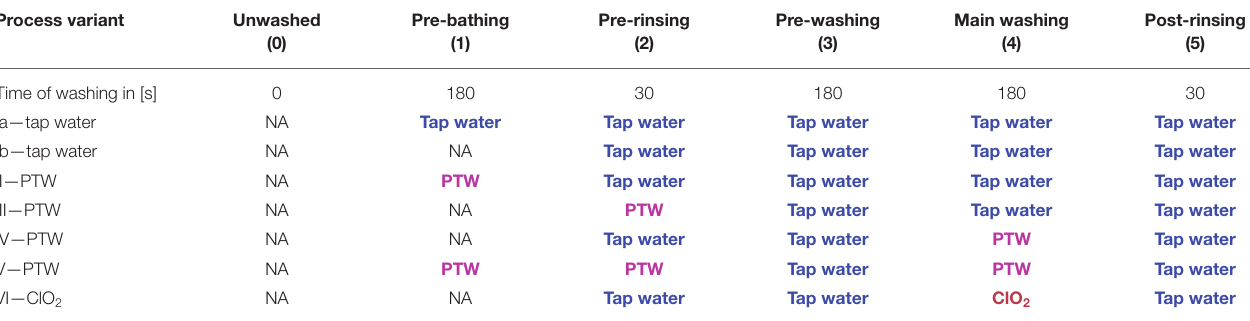
TABLE 1 | Investigated process variants included the application of PTW at various process stages and unwashed lettuce, tap water and chlorine dioxide (ClO 2 , 15 ppm) were the reference treatments. Process variant